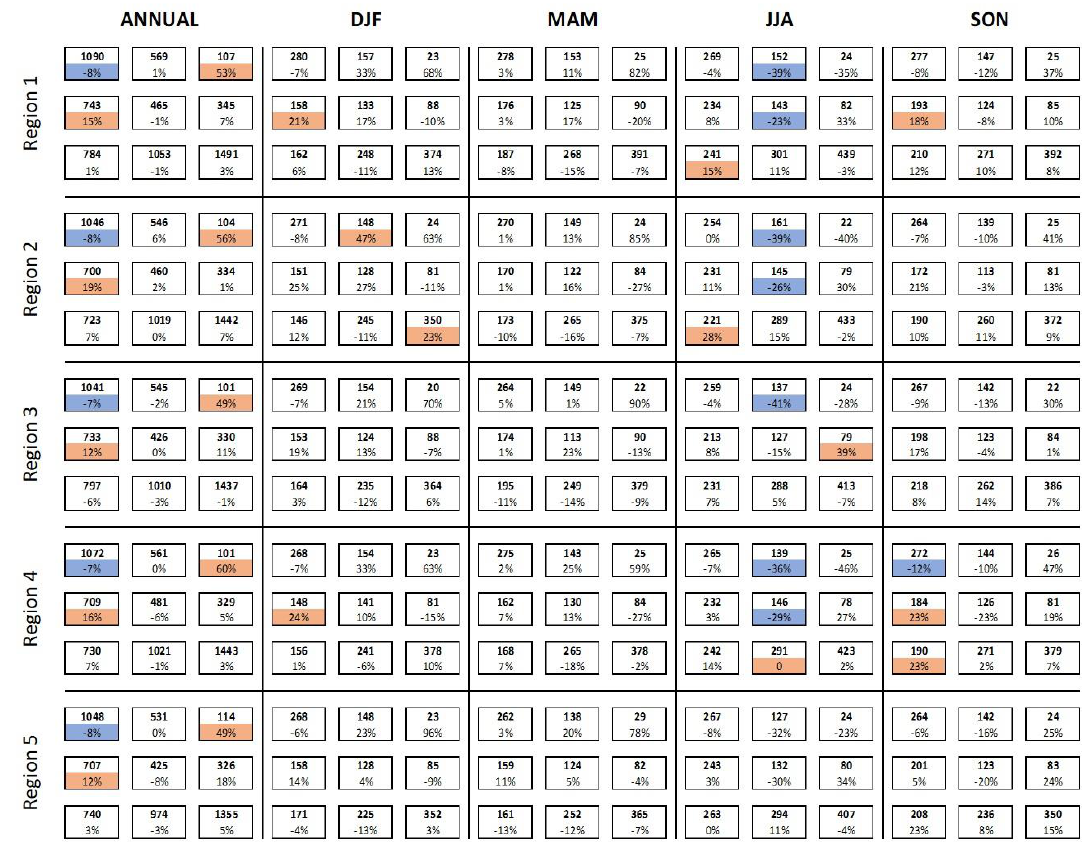
Figure 20. The number of wind speed events at 300 hPa for each type of event, region and season. For the historical climate (1st line of the cell) and the difference between the future and historical (2nd line of the cell). Shaded values indicate significant differences ( t -student 5%) positive (red) and negative (blue).